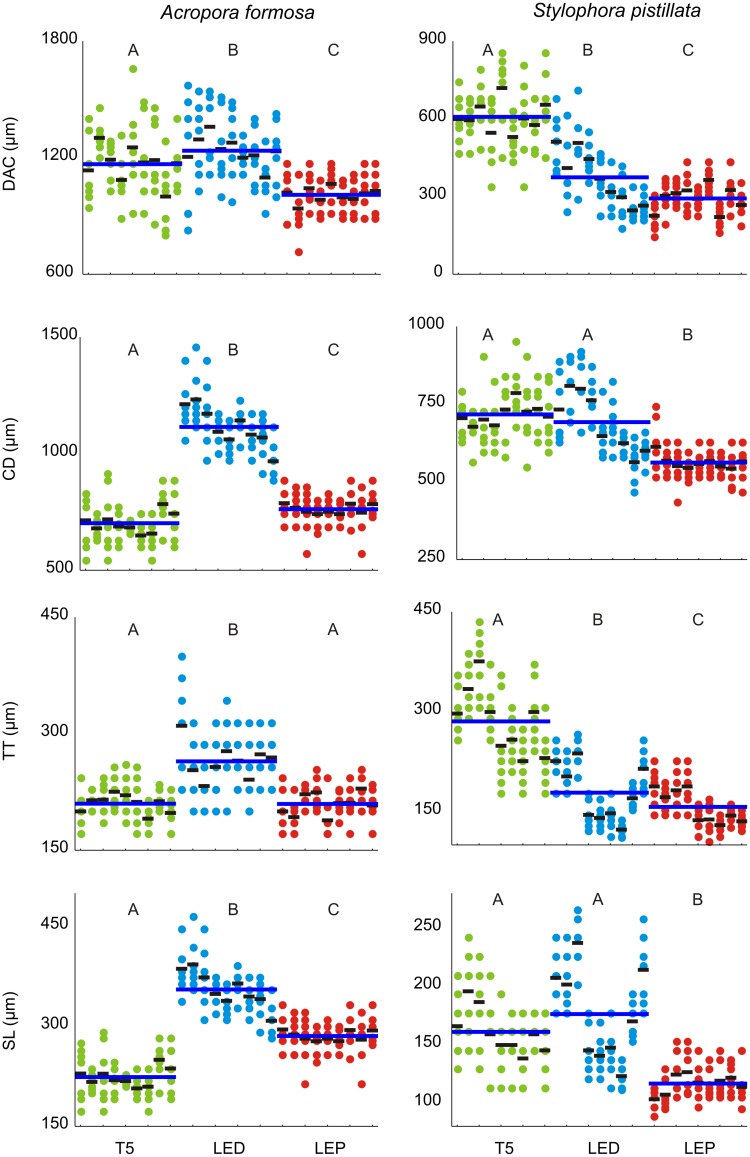
Morphometric parameters of A. formosa and S. pistillata corallites.Skeletal macrostructures obtained after SEM image analyses of coral fragments stocked under T5 fluorescent lamps (T5), light emitting diode (LED) and light emitting plasma (LEP). The blue horizontal line in each light treatment represents the average value for the distance among corallites (DAC), corallite diameter (CD), theca thickness (TT), and septal length (SL). The shorter black lines represent average measurements within each coral fragment. Different capital letters on the same graphic represent significant differences (p<0.05).